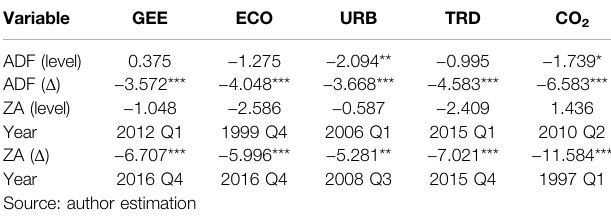
TABLE 3 | Results of the unit root